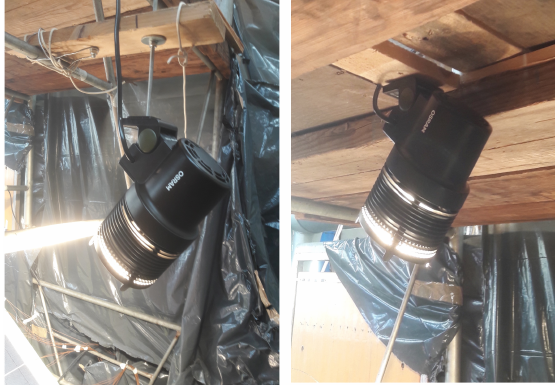
Figure 6. Lamp installation position over the PV module.